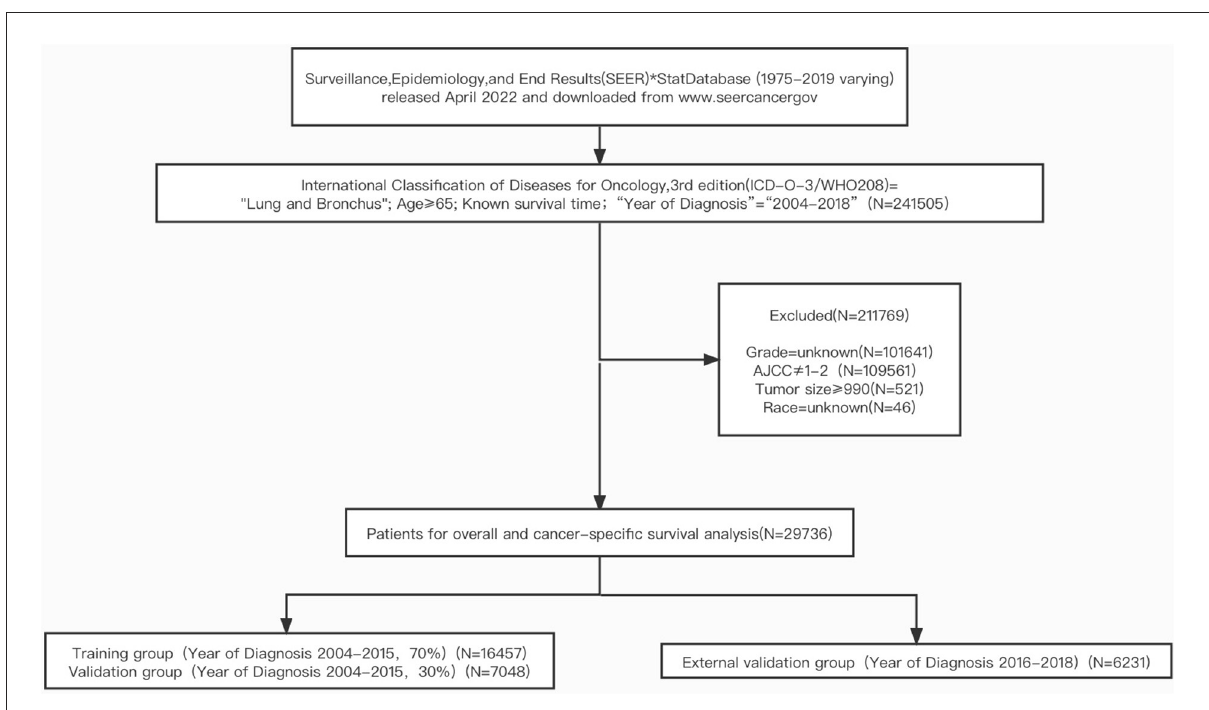
FIGURE1 The flowchart of including and dividing patients.